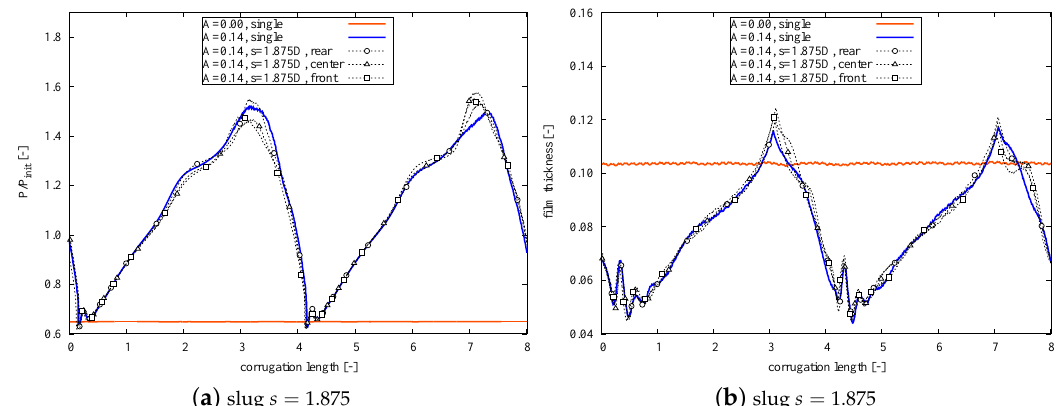
Figure 9. Single and multiple drops flow in channels with amplitudes A = 0.00 (straight channel, red color) and A = 0.14 (sinusoidal, blue color) in two corrugated lengths for ( a ) change in drop’s perimeter ratio P relative to its initial perimeter P init and ( b ) film thickness evolution. The figures stand for slug flow with drop’s initial slug lengths of s = 1.875. All parameters are dimensionless.